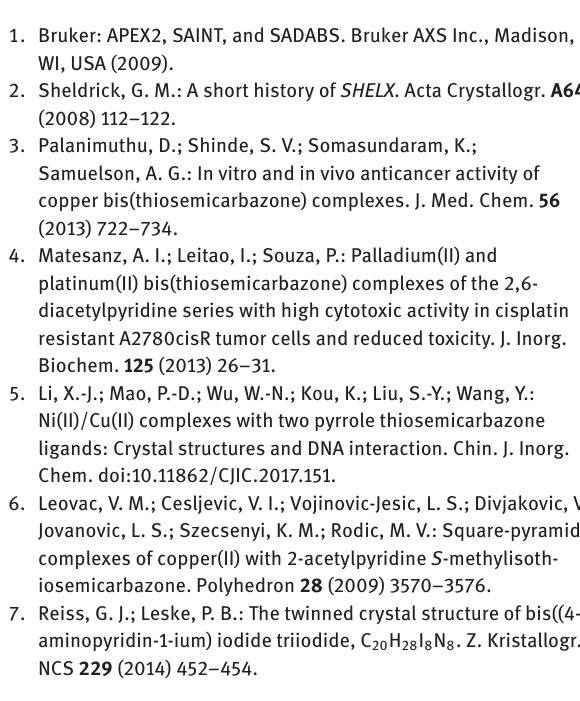
unit. The bond length of C7—N3 of the thiosemicarbazone moeity is 1.317(4) Å, which is quite shorter than that of the normal C—N bond, while slightly longer than that of the com- mon C = N bond. This fact indicates that the C7—N3 should be a double bond and the N3 atoms may be protonated. In the crystal, intermolecular N—H· · · I hydrogen bonds between all terminal N—H donors of the title cation and the iodide anions link them into a 2D supermolecular network. The